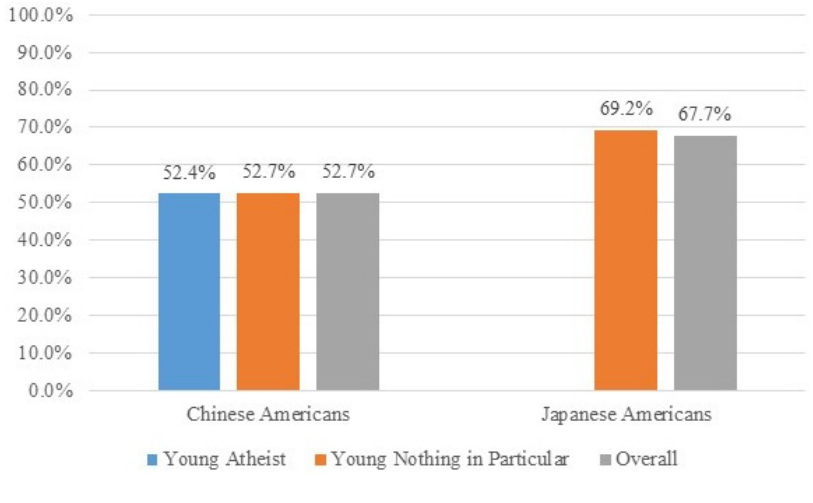
Figure 18. Getting along with blacks.